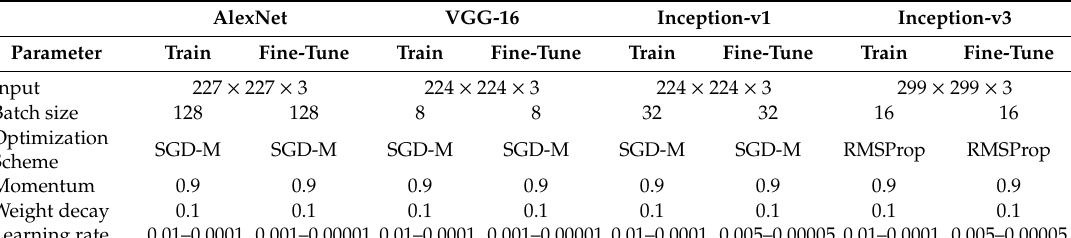
Table 1. Network training and fine-tuning